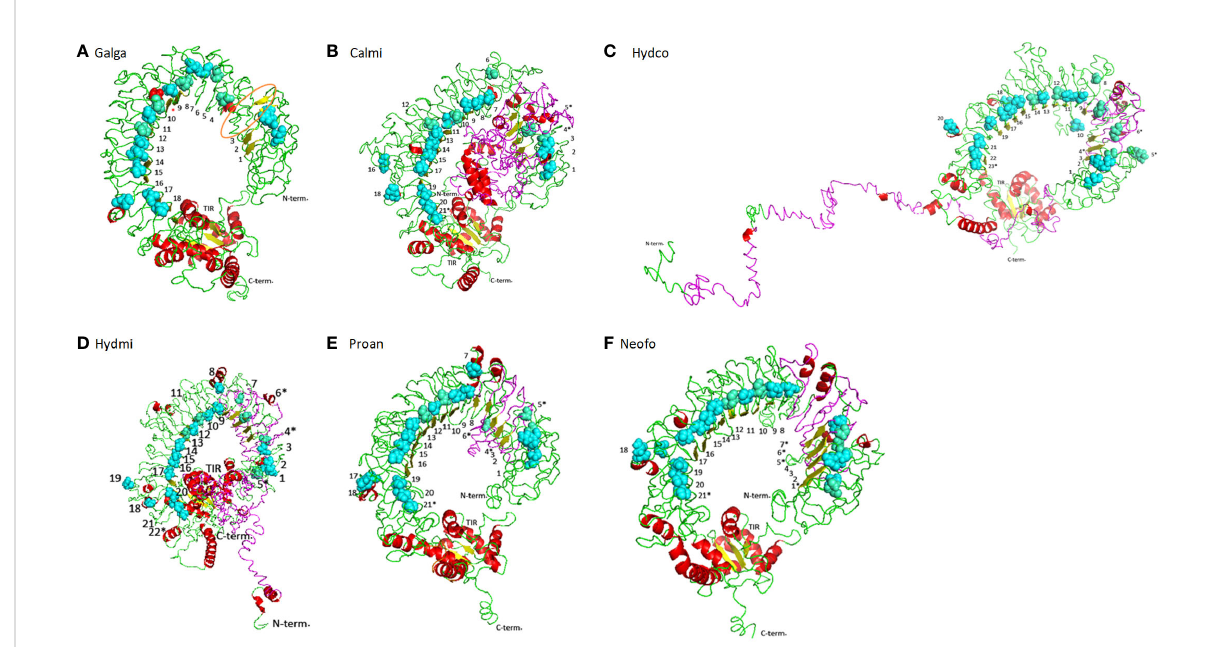
FIGURE 4 Structural conformation on cartoon mode of the TLR15 in different vertebrates. (A) Chicken TLR15 used as a model. The predicted long loop Chicken TLR15 used as a model. The predicted long loop between LRR3 and LRR4 modules is highlighted in orange and the LRR motif detected in other studies (48) is marked with a red asterisk; (B) Callorhinchus milli ; (C) Hydrolagus colliei ; (D) Hydrolagus mirabilis ; (E) Protopterus annectens ; and (F) Neoceratodus forsteri . The structures are shown in cartoon mode. The asparagines ladder positions are shown by sphere mode in cyan while the broken asparagines ladder are in greencyan. The LRR N-terminal (N-term) and C-terminal (C-term) and TIR domain detected modules are labeled and LRR modules are